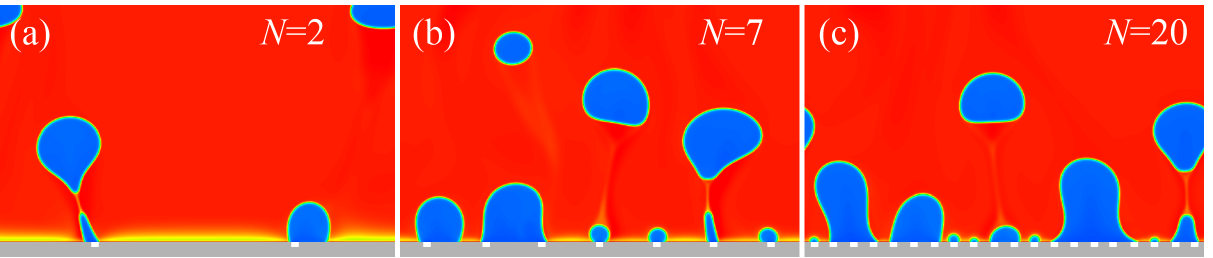
Figure 8. The density contour plots of boiling at Δ T = 0.065 T c for different numbers of the lyophobic zones: ( а ) N = 2 ( L / D d ≈ 4.61), ( b ) N = 7 ( L / D d ≈ 1.3), ( c ) N = 20 ( L / D d ≈ 0.62).